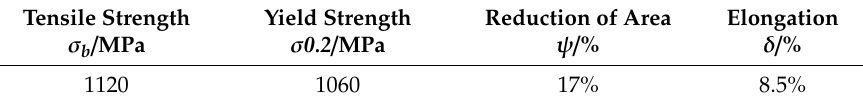
Table 2. Mechanical properties of TC18 titanium alloy [23].